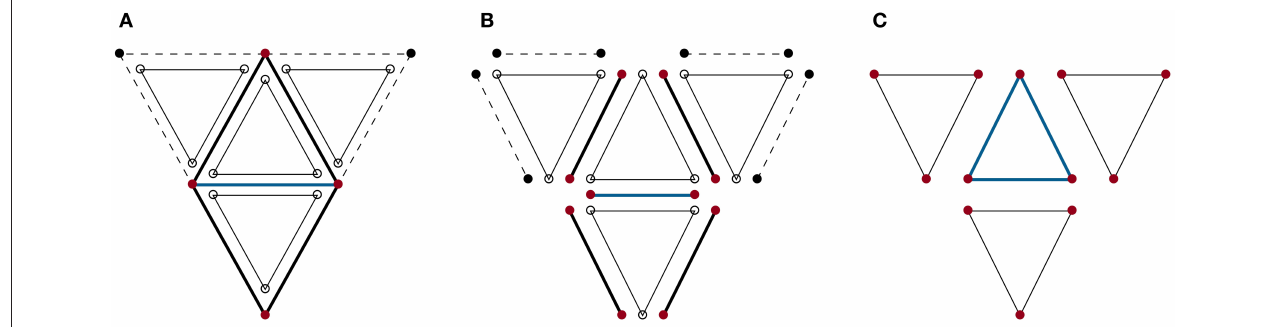
FIGURE 1 | Stencil for a generic element (triangle or edge in blue) for the Embedded— (A) , Hybridized— (B) , and Weighted— (C) . Interior Penalty discretization with polynomial order k = 1. For all methods, the nodes corresponding to degrees of freedom for the generic element are marked as solid red